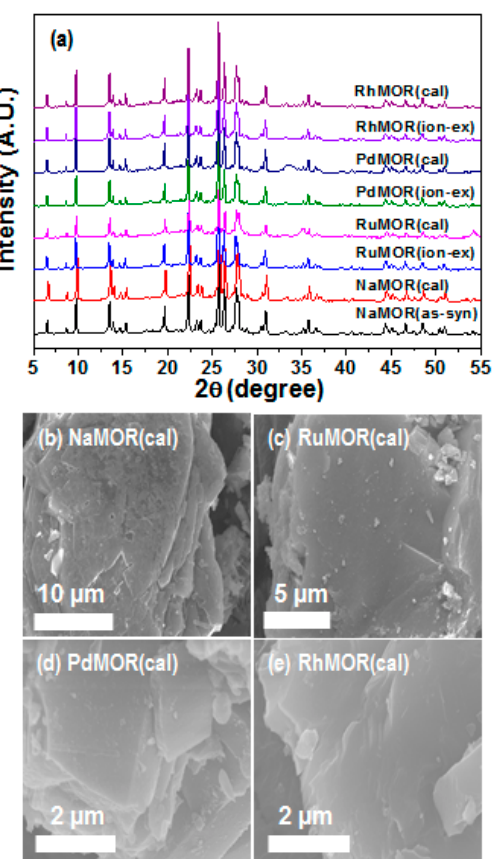
Figure 1. ( a ) X-ray diffraction (XRD) patterns of as-synthesized metal ion-exchanged mordenite (MOR) zeolite in the Na + -form (NaMOR(as-syn)), its calcined form (NaMOR(cal)), noble metal ion- exchanged MOR zeolites (XMOR(ion-ex), where X is Ru, Pd or Rh) and their calcined forms (XMOR(cal)). ( b – e ) SEM images of calcined MOR zeolite samples (NaMOR(cal), RuMOR(cal), PdMOR(cal) and RhMOR(cal).